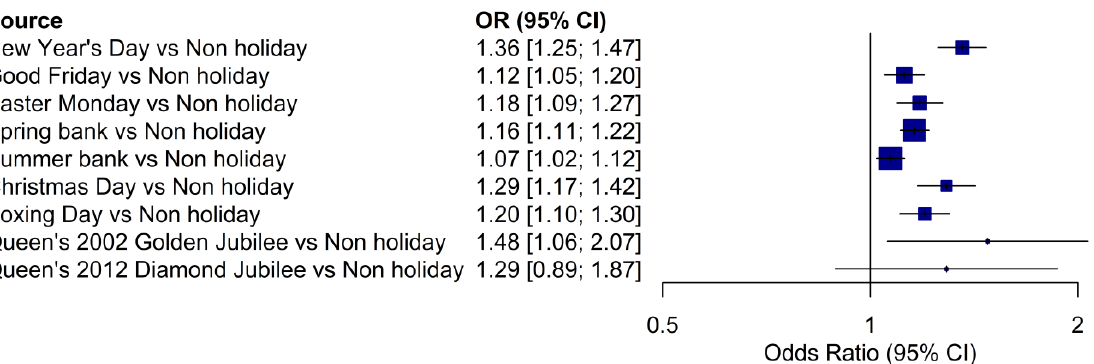
Figure A5. Forest plot of odds ratio from multiple logistic regression by different type of holidays using the UK STATS19 data [24].